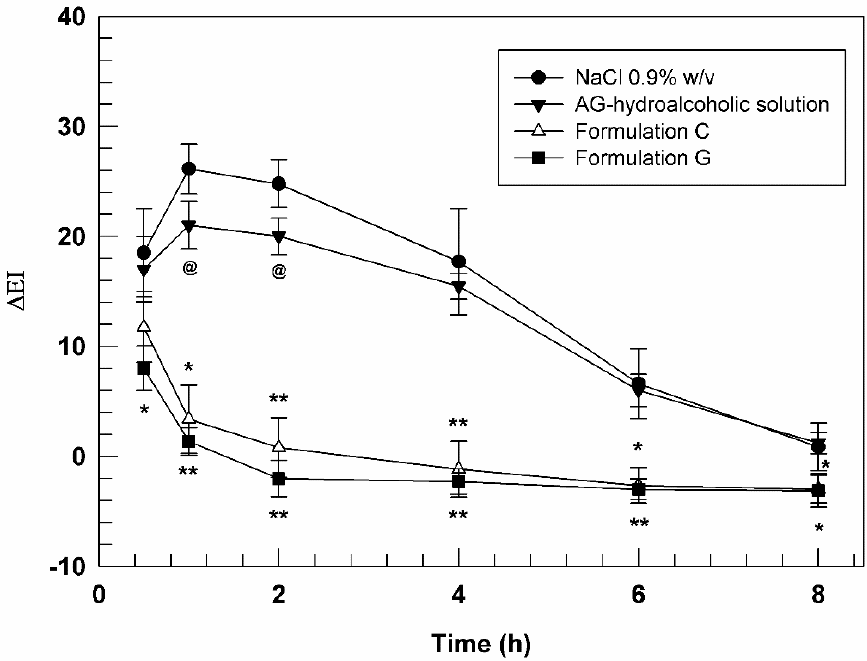
Figure 7. In vivo anti-inflammatory activity evaluation of AG hydroalcoholic solution, Formulation C and Formulation G. The results (mean values of five different experiments ± standard deviation) are expressed as erythema index variation ( Δ EI) versus time. The AG-hydroalcoholic solution was compared to saline solution (@ p < 0.05), while data obtained testing formulation C and G were compared to the ones carried out by AG-hydroalcoholic solution. * p < 0.05, ** p < 0.001.